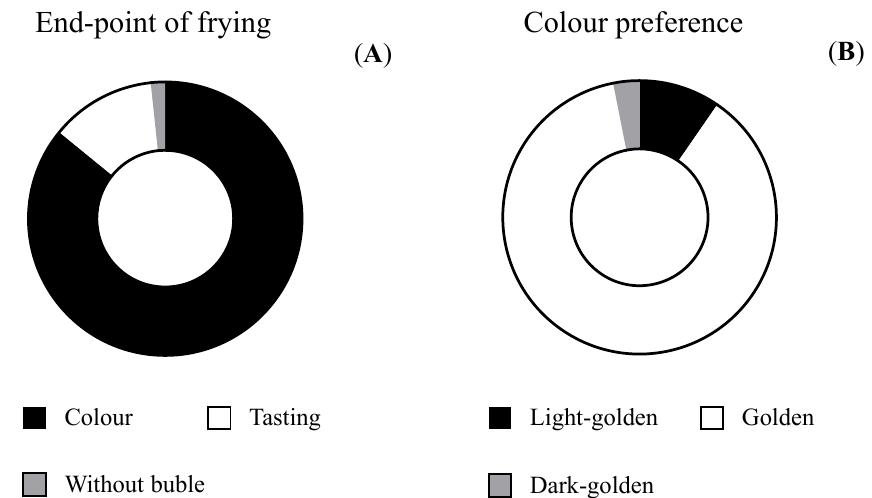
Figure 6. Criteria to decide the frying end-point ( A ) and color preferences in relation to french fries ( B ).